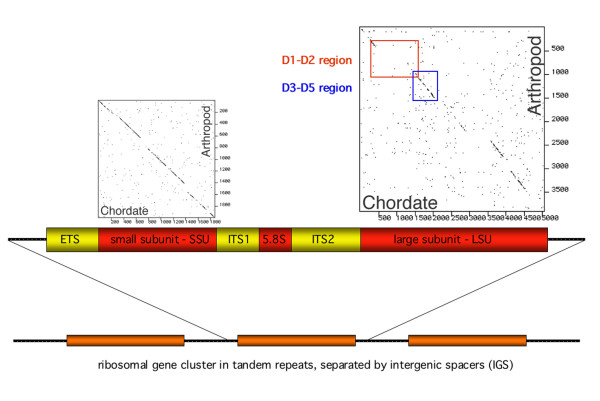
General organisation of eukaryotic ribosomal genes. All eukaryotes show a stereotypic arrangement, with often hundreds of tandemly repeated ribosomal transcription units. Each produces a large transcript which is processed into the small subunit, the 5.8S subunit and the large subunit. The external transcribed spacer (ETS) and the internal transcribed spacers (ITS1 and ITS2) do not become part of the mature rRNA, but their sequences and structures are required for the correct processing. The dot plot comparisons above the SSU and the LSU show the conservation profiles between a chordate and an arthropod sequence. In this presentation, the sequences of two species (mouse and Drosophila) are compared and a dot is placed in the diagram at each position where 10 consecutive nucleotides match. Conserved and divergent regions become thus directly apparent. It is evident that the SSU is more conserved, interrupted by a few less conserved regions, while the LSU show larger regions of divergence.